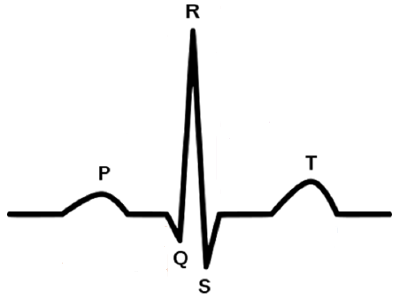
Figure 1. Fiducial PQRST. Based on